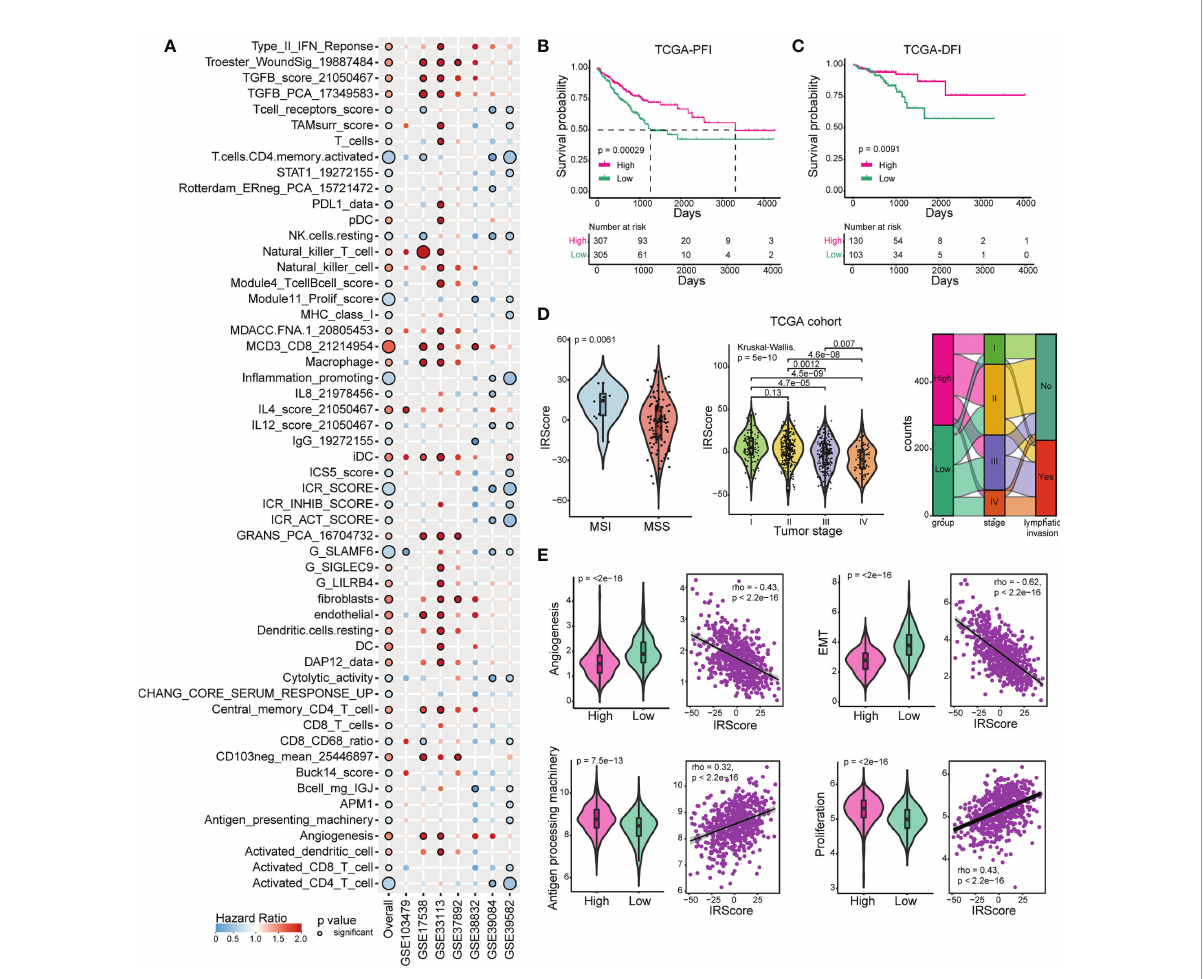
FIGURE 1 Construction and exploration of IRScore in CRC cohorts. (A) . Immune-related signatures with survival signi fi cance in CRC. Circles with black border represent prognostic signi fi cance of the signature in corresponding cohort, and the size of circles represents the signi fi cance level. Red circles represent Hazard Ratio (HR) >1, implying prognostically “ bad ” signatures, and blue circles represent HR< 1, implying prognostically “ good ” signatures. (B, C) Kaplan-Meier curves of progression-free interval (PFI, B ) and disease-free interval (DFI, C ) based on IRScore groups in TCGA cohort. (D) . Violin plots showing the relationship between IRScore and MSI/MSS (left), tumor stages (middle), and Sankey diagram illustrating the relationship between IRScore and CRC subtypes in TCGA cohort. (E) . The association and correlation between IRScore and gene signatures (angiogenesis, EMT, antigen presenting machinery and proliferation) in TCGA cohort illustrated by violin plots (left) and scatter plots with trend lines (right) in TCGA